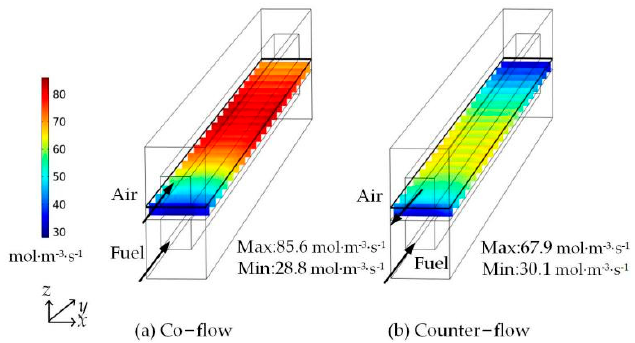
Figure 10. Distribution of MSR reaction rate for case C.